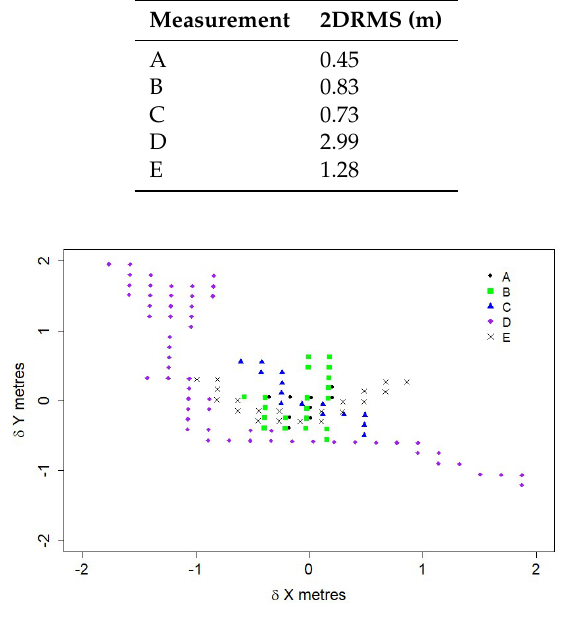
Table 3. Summary of horizontal error for different augmentation techniques.